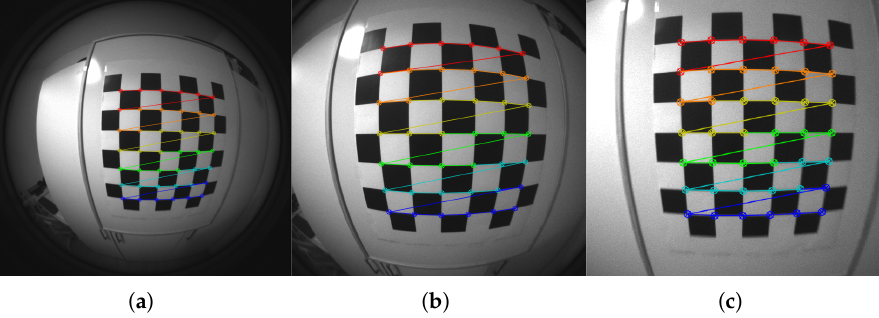
Figure 6. ( a ) 848 × 800 px; ( b ) 636 × 600 px; ( c ) 424 × 400 px. ROS camera-calibration process capture for each of the resolutions selected with the respective target feature extraction. The marker employed is a 7 × 6 chessboard with a square size of 5.9 cm.